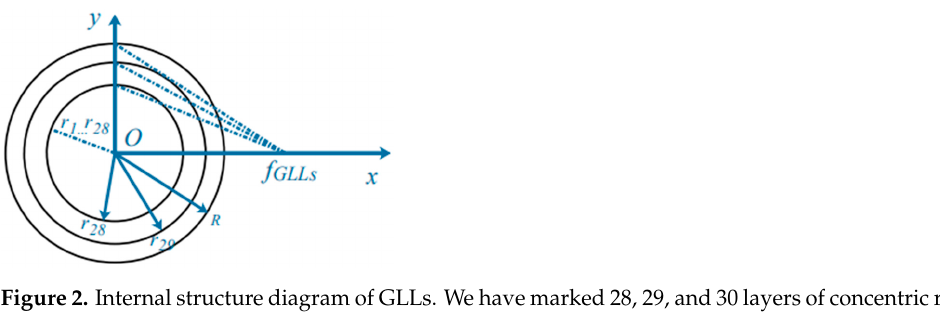
Figure 3. PJ generated by a plane wave illuminating a GLLs. In the figure, plane waves, GLLs, photonic jets, and nanorods and some of their parameters (such as the maximum radius R and the focal length f GLLs of GLLs, the focal point of the photonic jet, the focal length f and FWHM ) are marked respectively. GLLs are composed of 30 layers of concentric rings with different refractive indexes centered on the center of the sphere.